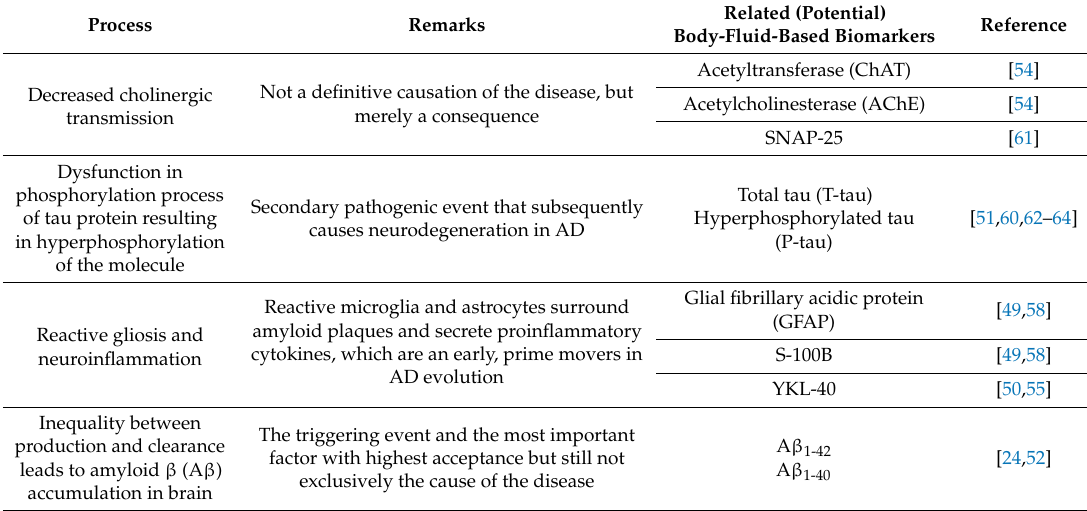
Table 1. Alzheimer’s disease (AD)-related processes and the corresponding potential body-fluid-based biomarkers. It should be noted that some of these compounds are not specific for AD but may be of value by having a role in AD